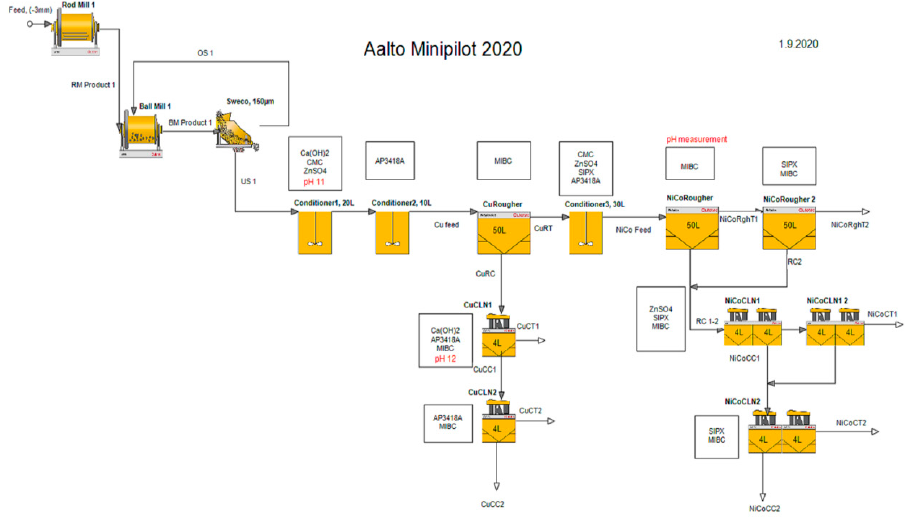
Figure 8. Flowsheet of the mini-pilot process created with the HSC Chemistry software.